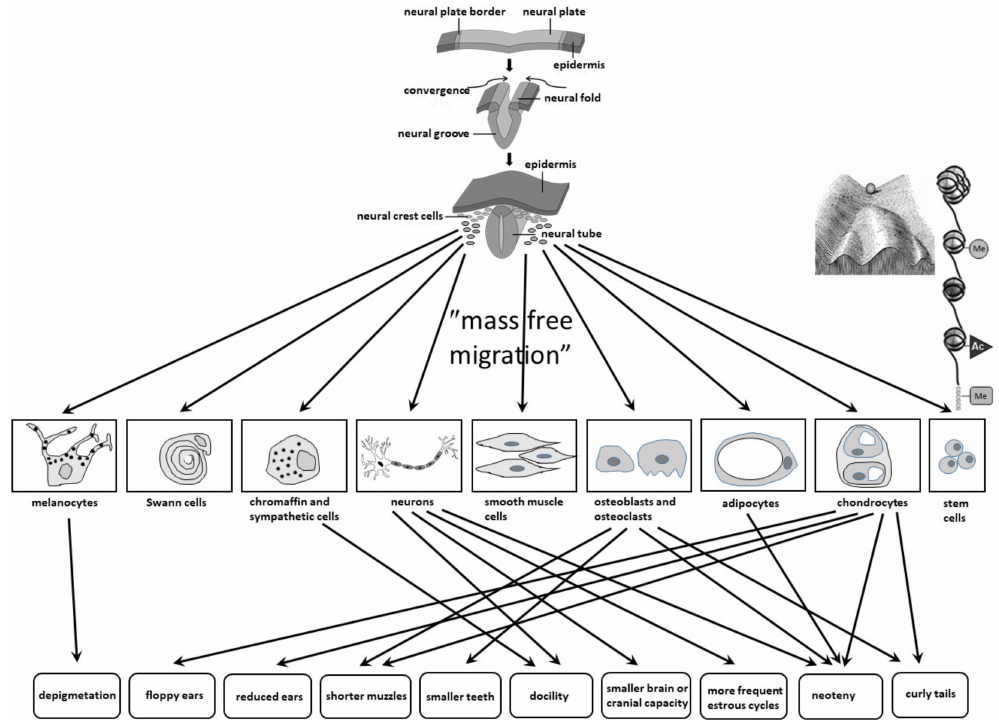
Figure 1. Schematic representation of neural tube development, neural crest cells (NCCs) migration, and some associations of NCCs with phenotypic traits of the domestication syndrome in mammals. The upper part of the schematics is made according to Marieb and Hoehn (2018) [27] and Kaltschmidt et al. (2018) [28]. The Waddington’s epigenetic landscape (“ canalization ”) on the right side illustrates contribution of epigenetic changes on NCCs migration, differentiation, and proliferation, and is made according to Strobl-Mazzulla and Bronner (2014) [29]. For the purpose of this schematic representation, no distinction is made between anterior (cephalic) and posterior somatic